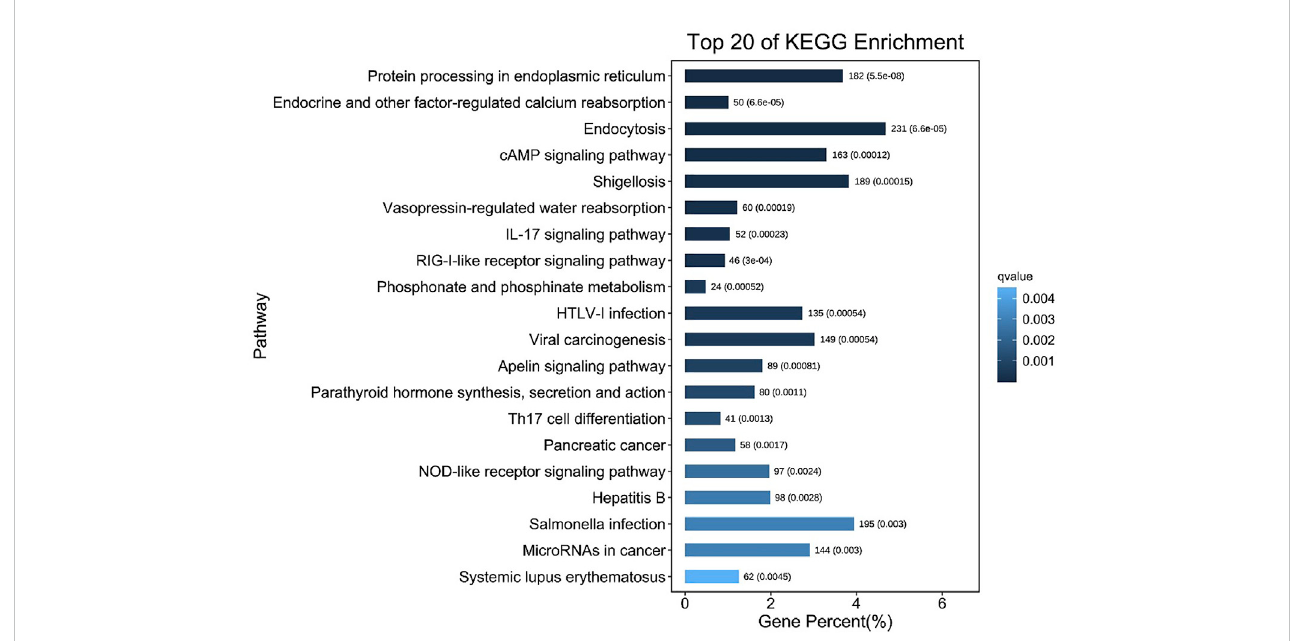
The top 20 pathways containing most number of DEmiRNAs target genes.